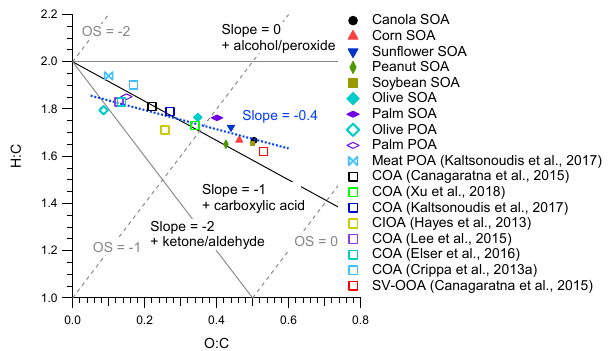
Figure 7. Average PMF SOA factor mass spectrum and ambient SV-OOA factor mass spectrum (Ng et al., 2011a).